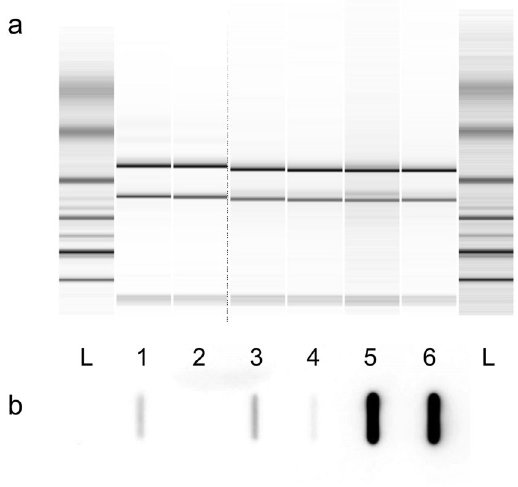
Figure 2. Slot blot analysis of AprAs transcription in B . licheniformis MW3 and B . licheniformis MW3 mutant strains. ( a ) The quality of the total RNA of B . licheniformis MW3 (lane 1), B . licheniformis MW3 AprAs −